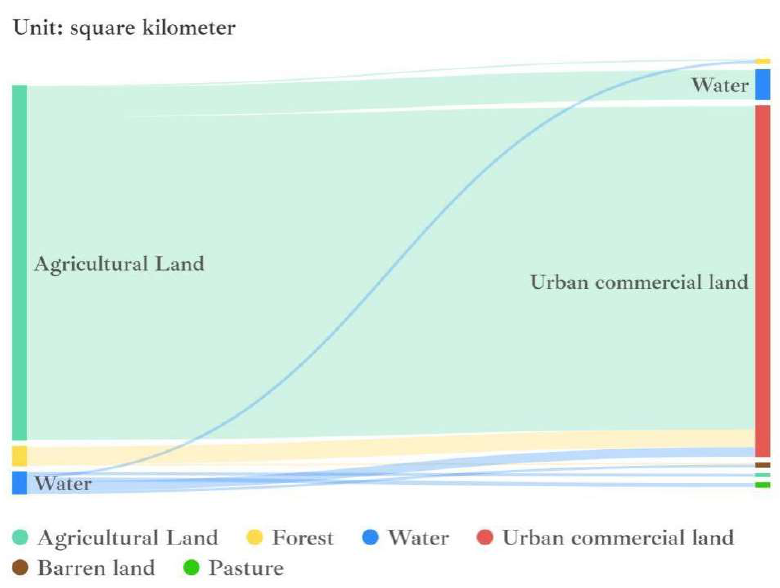
Figure 3. The land use changes in the Qinhuai River Basin from 1980 to 2015.